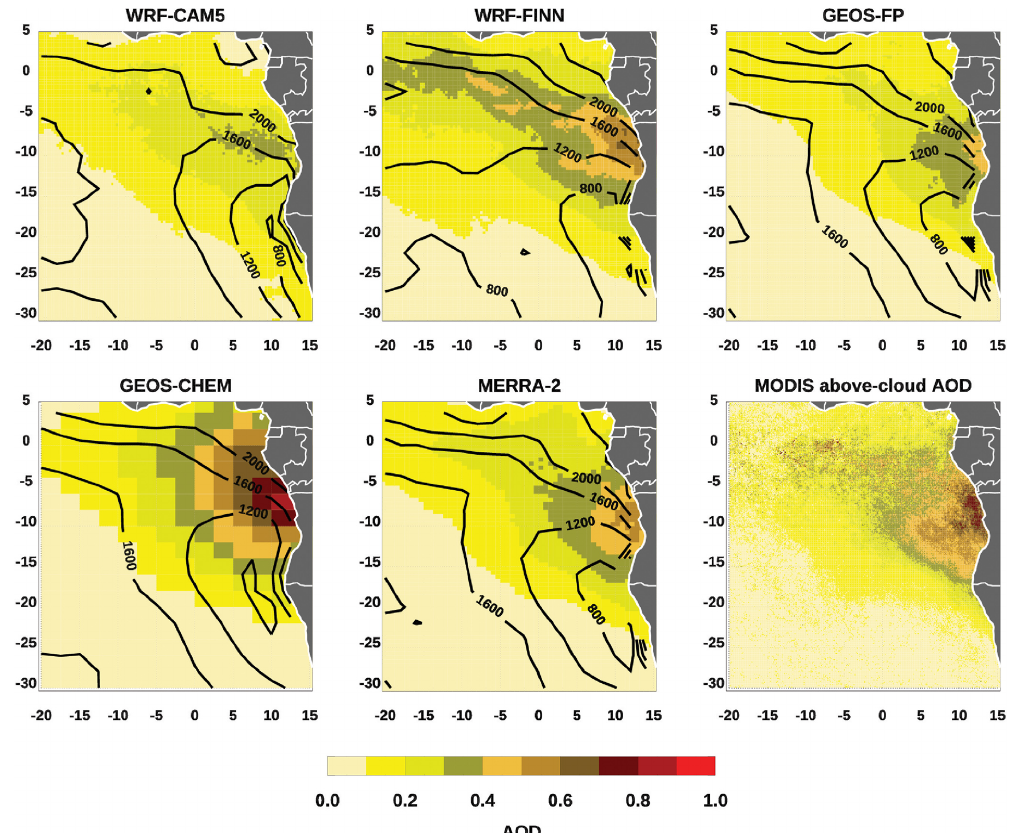
Figure 9. Monthly mean modeled AOD in the FT at 12:00UTC and MODIS (Terra and Aqua) above-cloud AOD for August 2017. Contours are PBL heights in